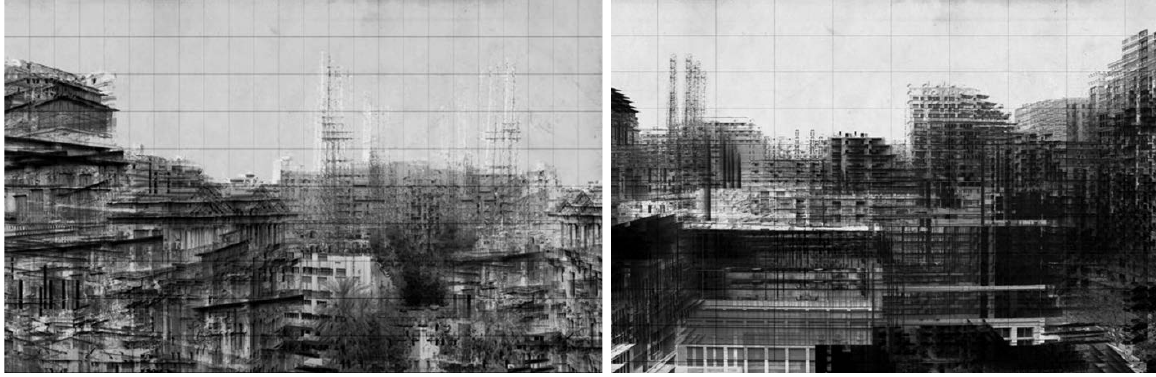
Figure 9. Amr Kafrawy: Printing and drawing on recycled paper, 220 x 100 cm